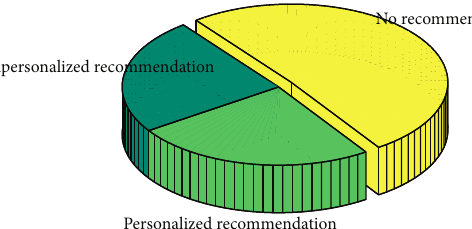
Figure 9: Specific content of the recommendation service provided by the smart library.